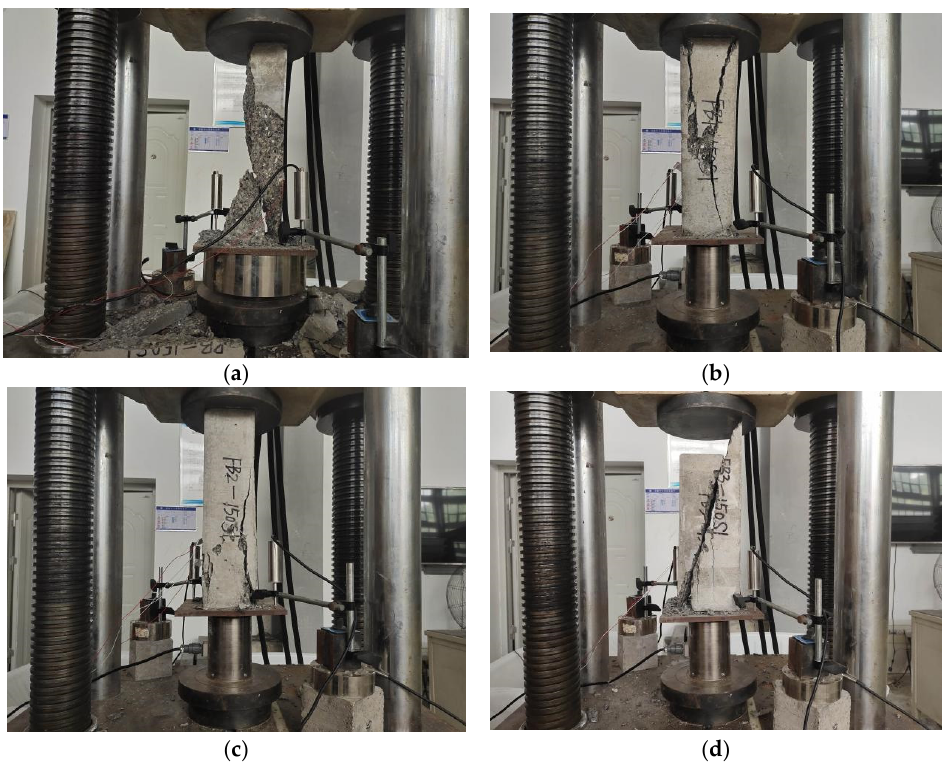
Figure 10. Damage characteristics of the specimen under uniaxial compression. ( a ) Volume fraction of 0%. ( b ) Volume fraction of 0.1%. ( c ) Volume fraction of 0.2%. ( d ) Volume fraction of 0.3%.